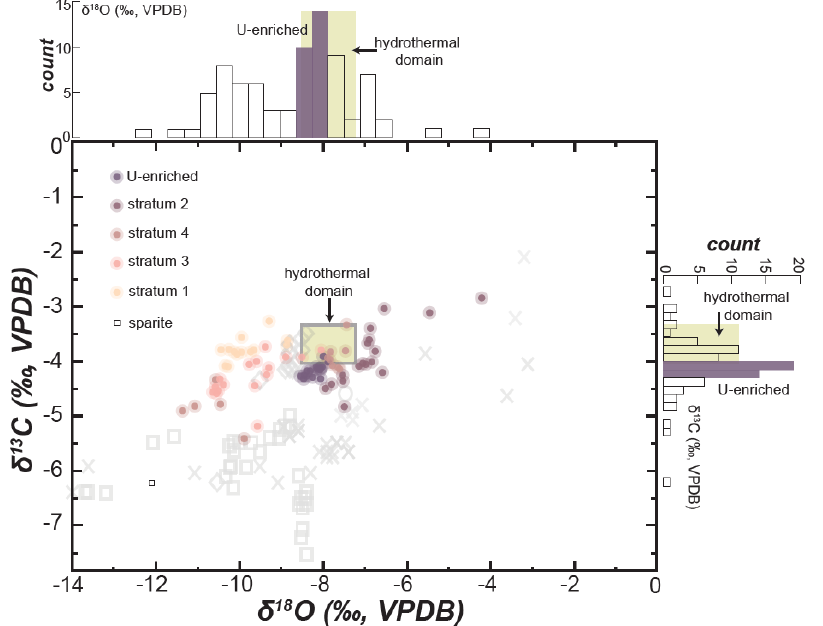
Figure 9. Stable isotope results for the studied palustrine carbonate. The cross plot indicates the δ 18 O and δ 13 C values of specific strata in the sample. The light gray symbols reflect the summary data from the Cedar Mountain Fm. from Figure 3, for comparison. Sparite from a vug is indicated by the open square symbol. Histograms on the ordinate axis and abscissa highlight the range of δ 18 O and δ 13 C values of the U-enriched portion of stratum 2 relative to the distribution of all of the strata. The hydrothermal domain is determined from the results of the clumped isotope analysis and reflects an interpretation of the calcite stable O and C isotope results of the clumped isotope analysis.